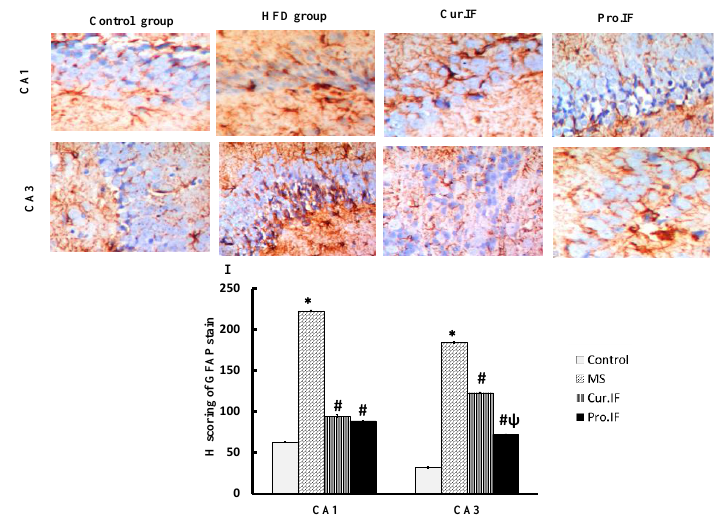
Figure 7. Effect of HFD and/or pro. and cur. IF on GFAP protein expression in the hippocampal sections in all studied groups. The figure shows significant increase in GFAP protein expression in CA1 and CA3 of HFD group. The cur. IF and pro. IF groups showed decreased GFAP protein ex- pression in the same areas. The histogram ( I ) declares the changes in H score in these areas. * HFD significant vis. control group, # pro. and cur. IF significant vis. HFD group, ψ pro. IF significant vise cur. IF.